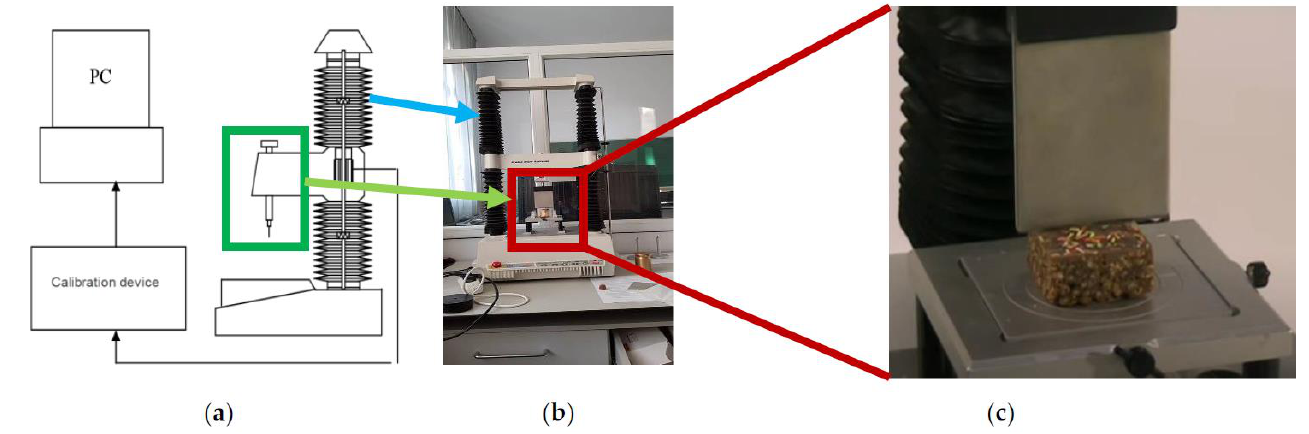
Figure 1. Texture Analyser-TA-XT2i [36]: ( a ) the analyzer’s technical system; ( b ) an image of the device in operation; ( c ) the cutting device. Table 1. Texture analysis was conducted to analyze various fruit species and varieties [22]. Item No.